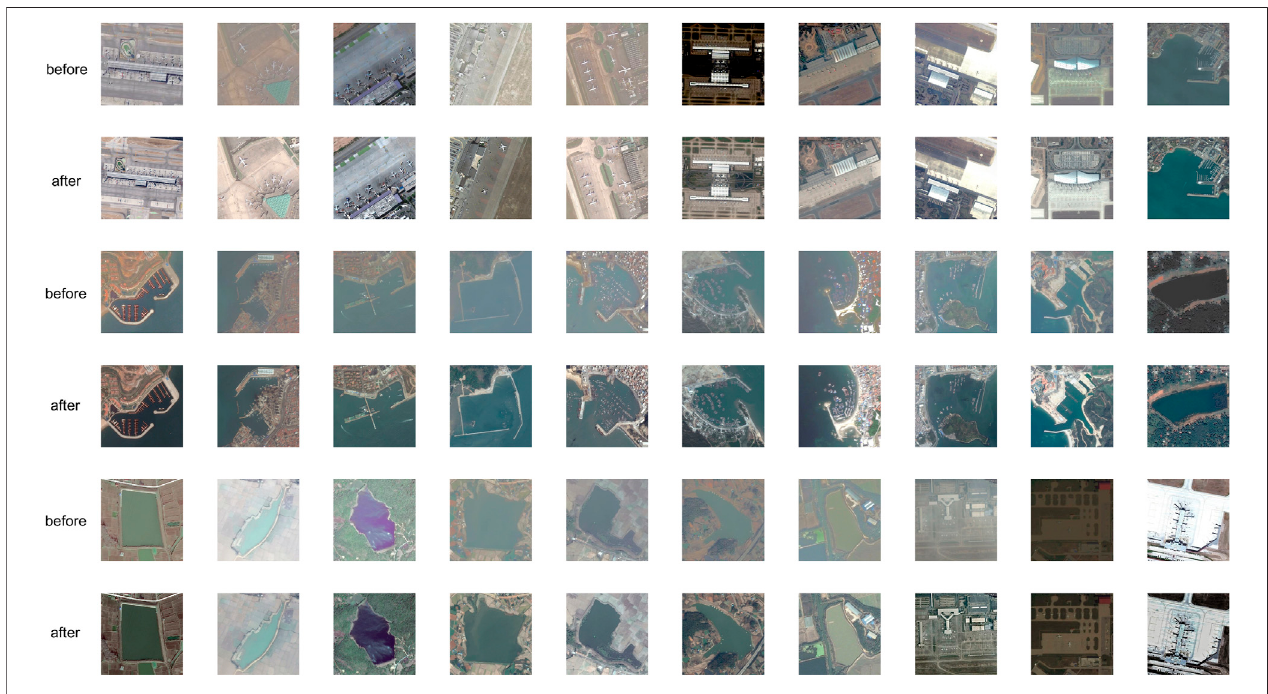
FIGURE 3 | Comparison of light and dark scenes before and after